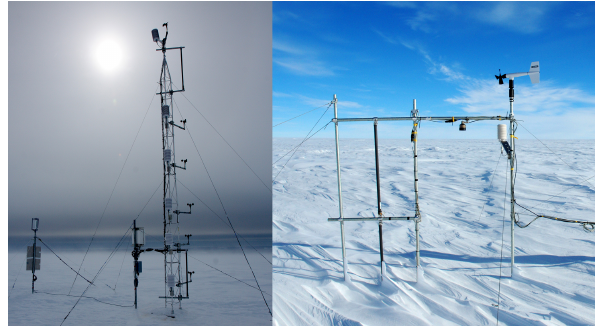
Figure 2. Left: the D17 7m mast with one second-generation FlowCapt ™ sensor. Right: the D47 automatic weather and snow sta- tion with two second-generation FlowCapt ™